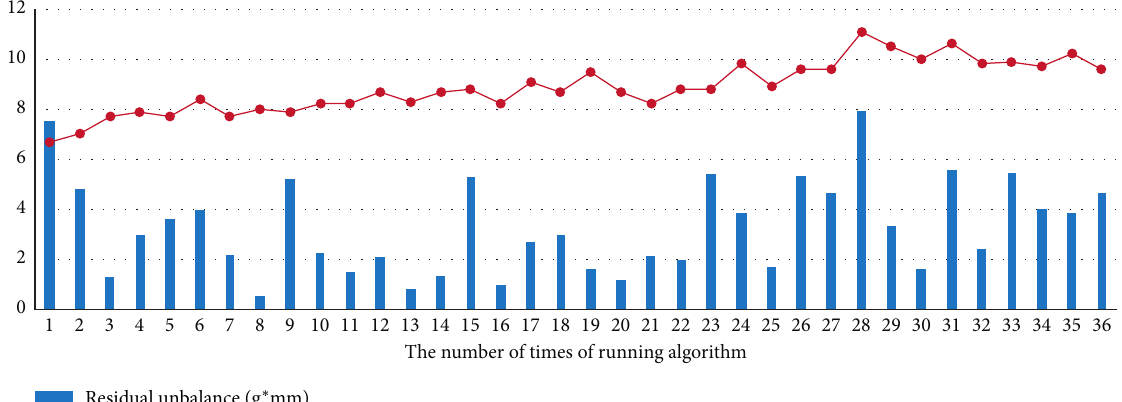
Figure 10: Statistical graph of the solution accuracy and solution time of the simulated annealing